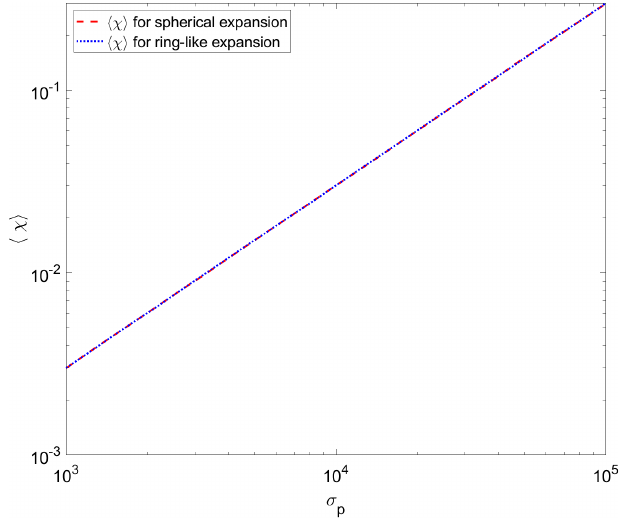
FIG. 3. Dependence of the mean χ -factor on the initial momentum deviation in a simulation series with j E j ¼ E 0